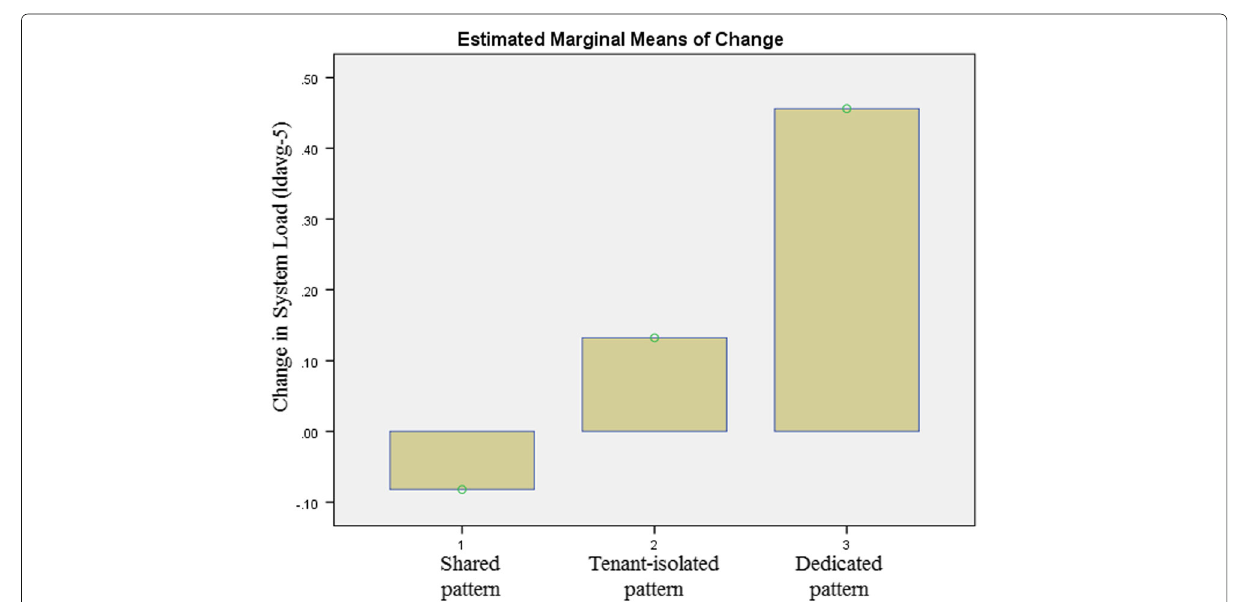
Fig. 28 Changes in System Load